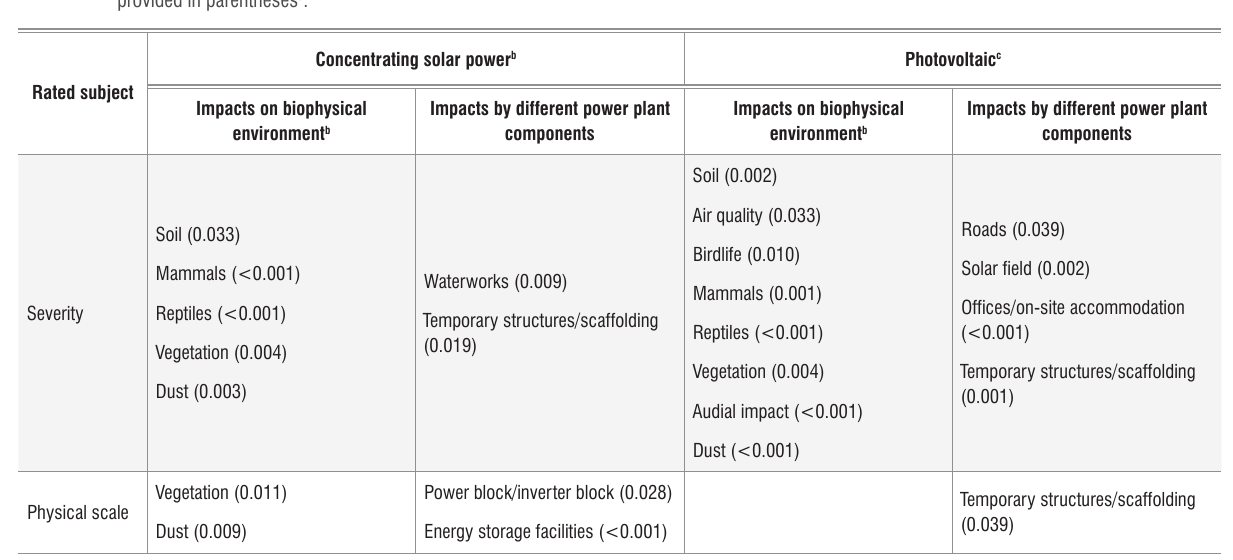
Table 3 summarises the p -values for (1) biophysical elements and (2) power plant components, for which a significant difference was found between the construction and operational stages. Here we see differences in impact severity between these two stages on almost all biophysical components for PV developments. No significant difference was found for the rated physical scale of biophysical impacts between the two development stages for PV. However, strong evidence of a significant difference between development stages was found for at least the physical scale of dust- and vegetation-related impacts from CSP developments. The results for the ratings of the power plant components show little consistency between CSP and PV developments. The only commonality is a significant difference between the two development